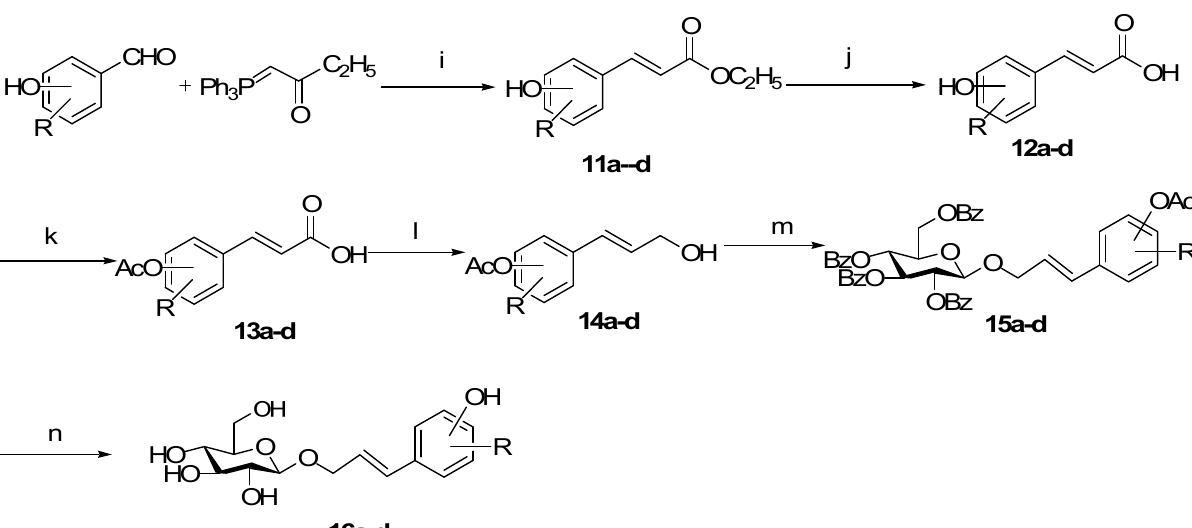
Scheme 2. The preparation of the target PPGs 16a-d